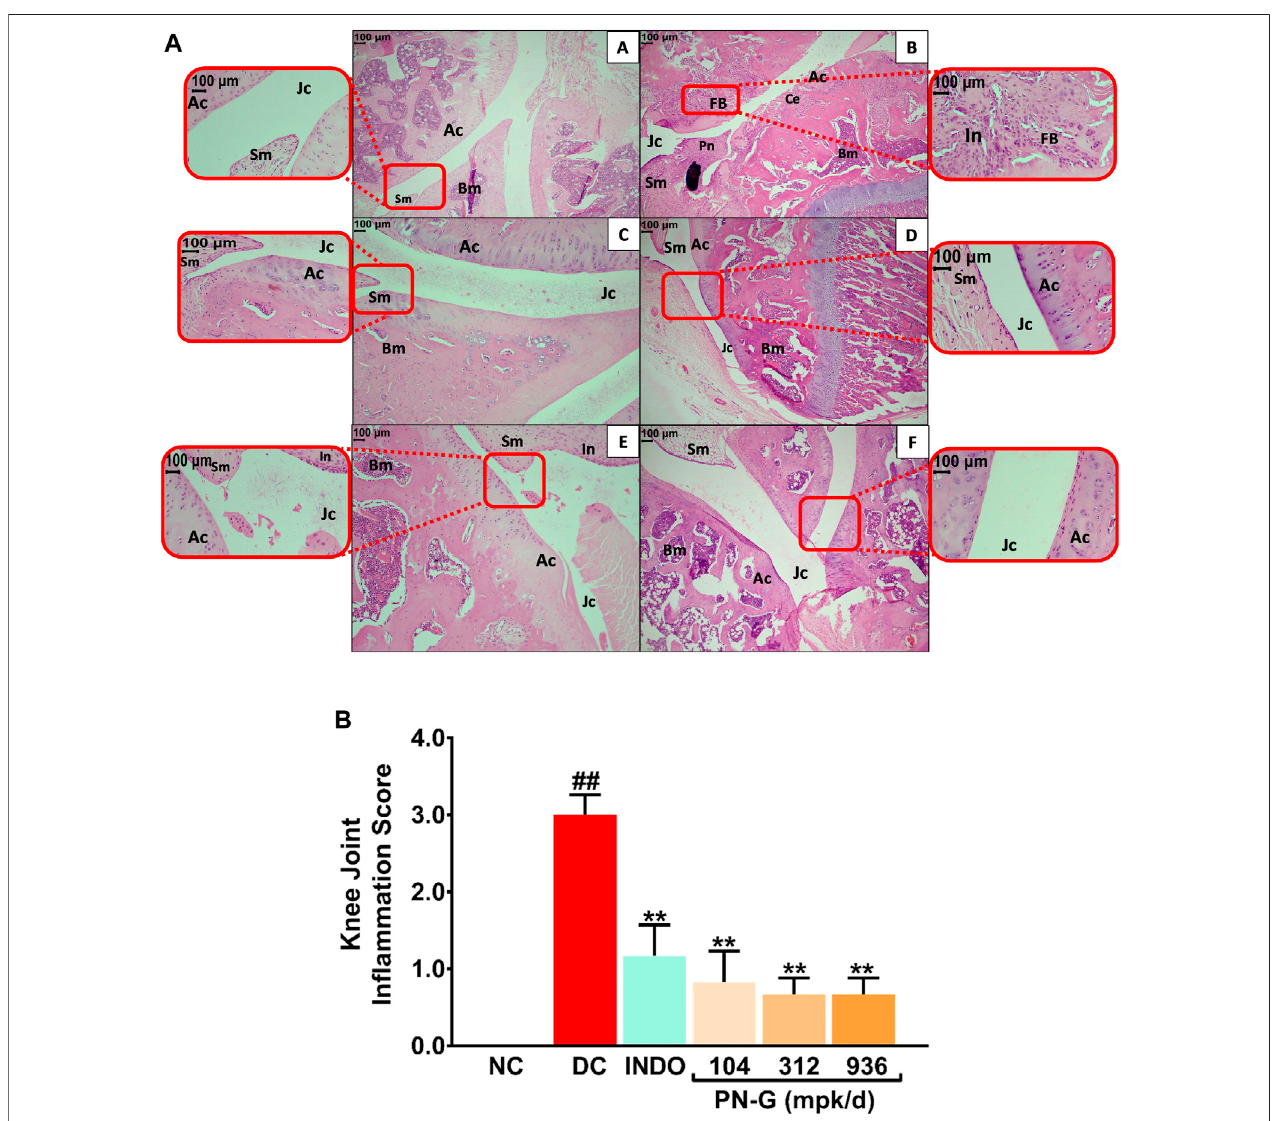
FIGURE6| PN-Gpreventedthein fl ammationinosteoarthriticjointtissues. (A) RepresentativemicrographsofH-Estainedrightkneejointsections,at×10and×40 magni fi cations, fromNC (A) ,DC (B) ,INDO (C) ,PN-G104 (D) ,PN-G 312 (E) andPN-G936 (F) groupsdepictingvarious histopathological features,like,normal articular cartilage(Ac),bonemarrowcells(Bm),synovialmembrane(Sm),jointcavity(Jc),cartilageerosion(Ce),super fi cial fi brillationofthearticularcartilage(FB),in fl ammation(In) and pannus formation (Pn). (B) Bar graph depicting the knee joint in fl ammation score. Data is presented as mean ± SEM ( n = 6 animals per group) and was statistically analyzed using one-way ANOVA followed by Dunnett ’ s multiple comparison test. ## depicts signi fi cant difference with respect to NC ( p < 0.01) whereas ** shows a statistically signi fi cant effect when compared to DC ( p <